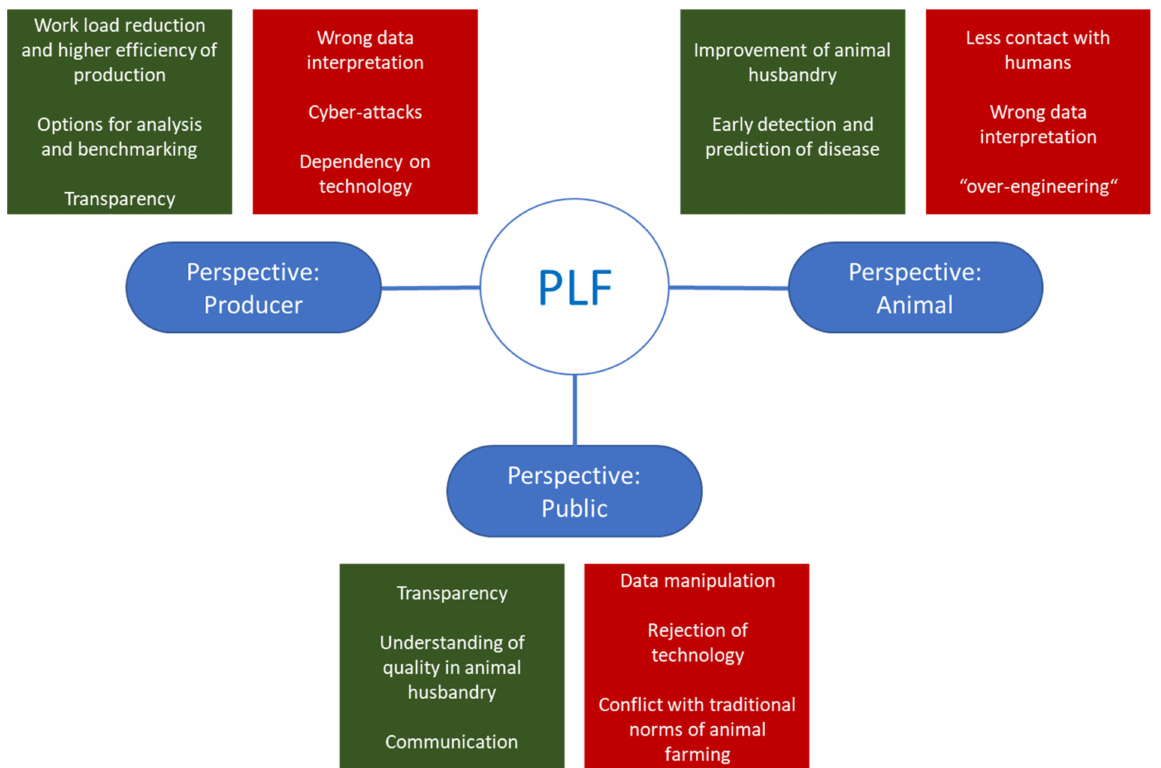
Figure 4. Evaluation of opportunities and risks of PLF. Summary based on (Raad voor Dierenaangele- genheiden [72]). From the different perspectives (animal, producer, public), different options